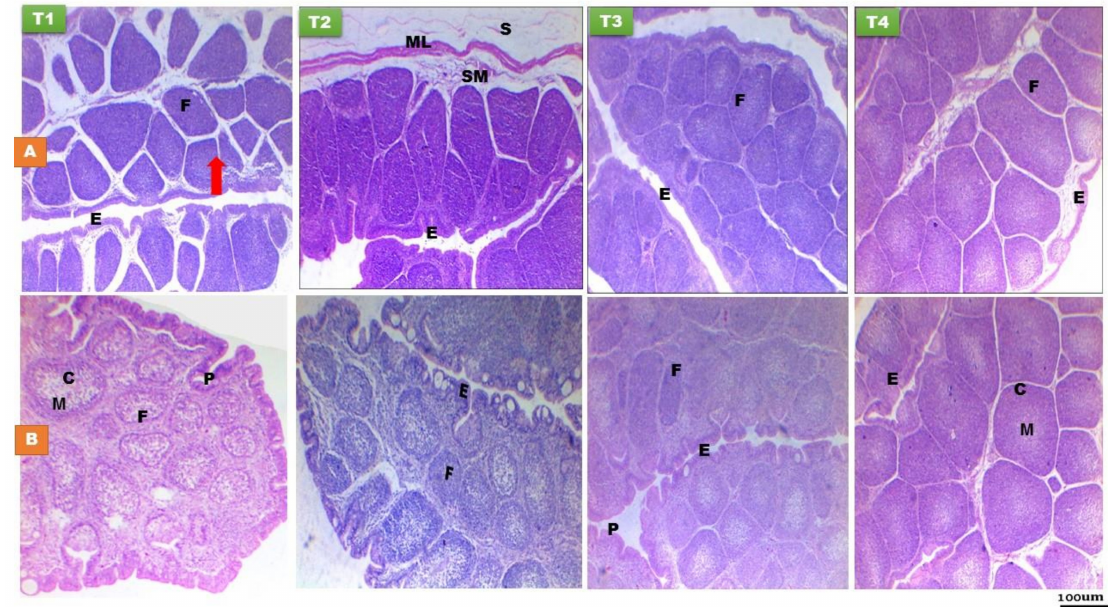
Figure 2. Histological structure of bursa of Fabricius at day 14 ( A ) and day 28 ( B ) of age of layer-type chicks exposed to fasting (control, T1) or early feeding on a layer starter diet (T2), a layer starter diet contained 3% molasses (T3), and a broiler starter diet (T4) during the first 72 h post-hatching. C, cortex; M, medulla; E, epithelium; P, Pelicae; F, follicle; SM, submucosa; ML, muscle layer; S, serosa. (H & E ×